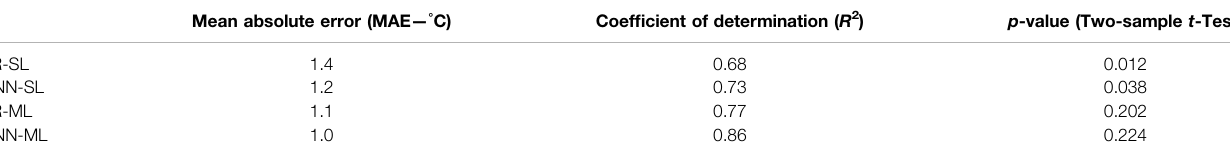
TABLE 2 | Statistical analysis of four applied learning algorithms on TensorFlow model using the Keras library in the testing process. Mean absolute error (MAE — °